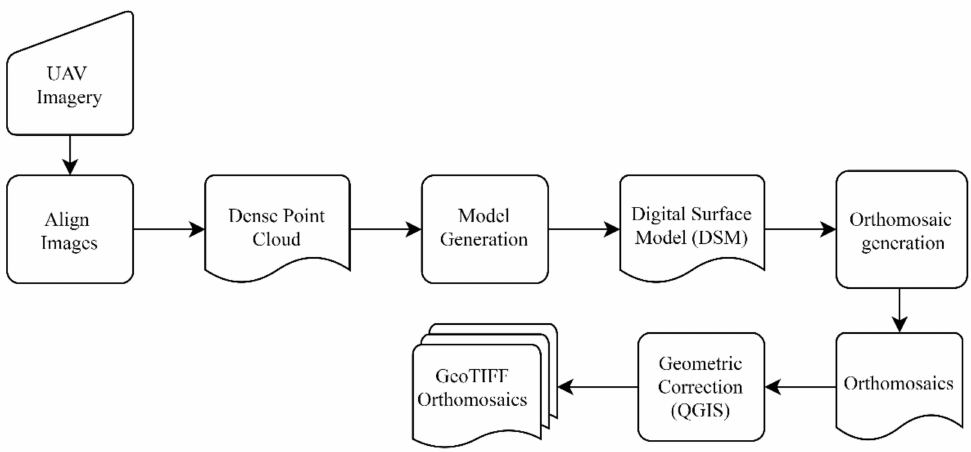
Figure 3. Workflow developed for processing the UAV images to obtain the georeferenced orthomo-